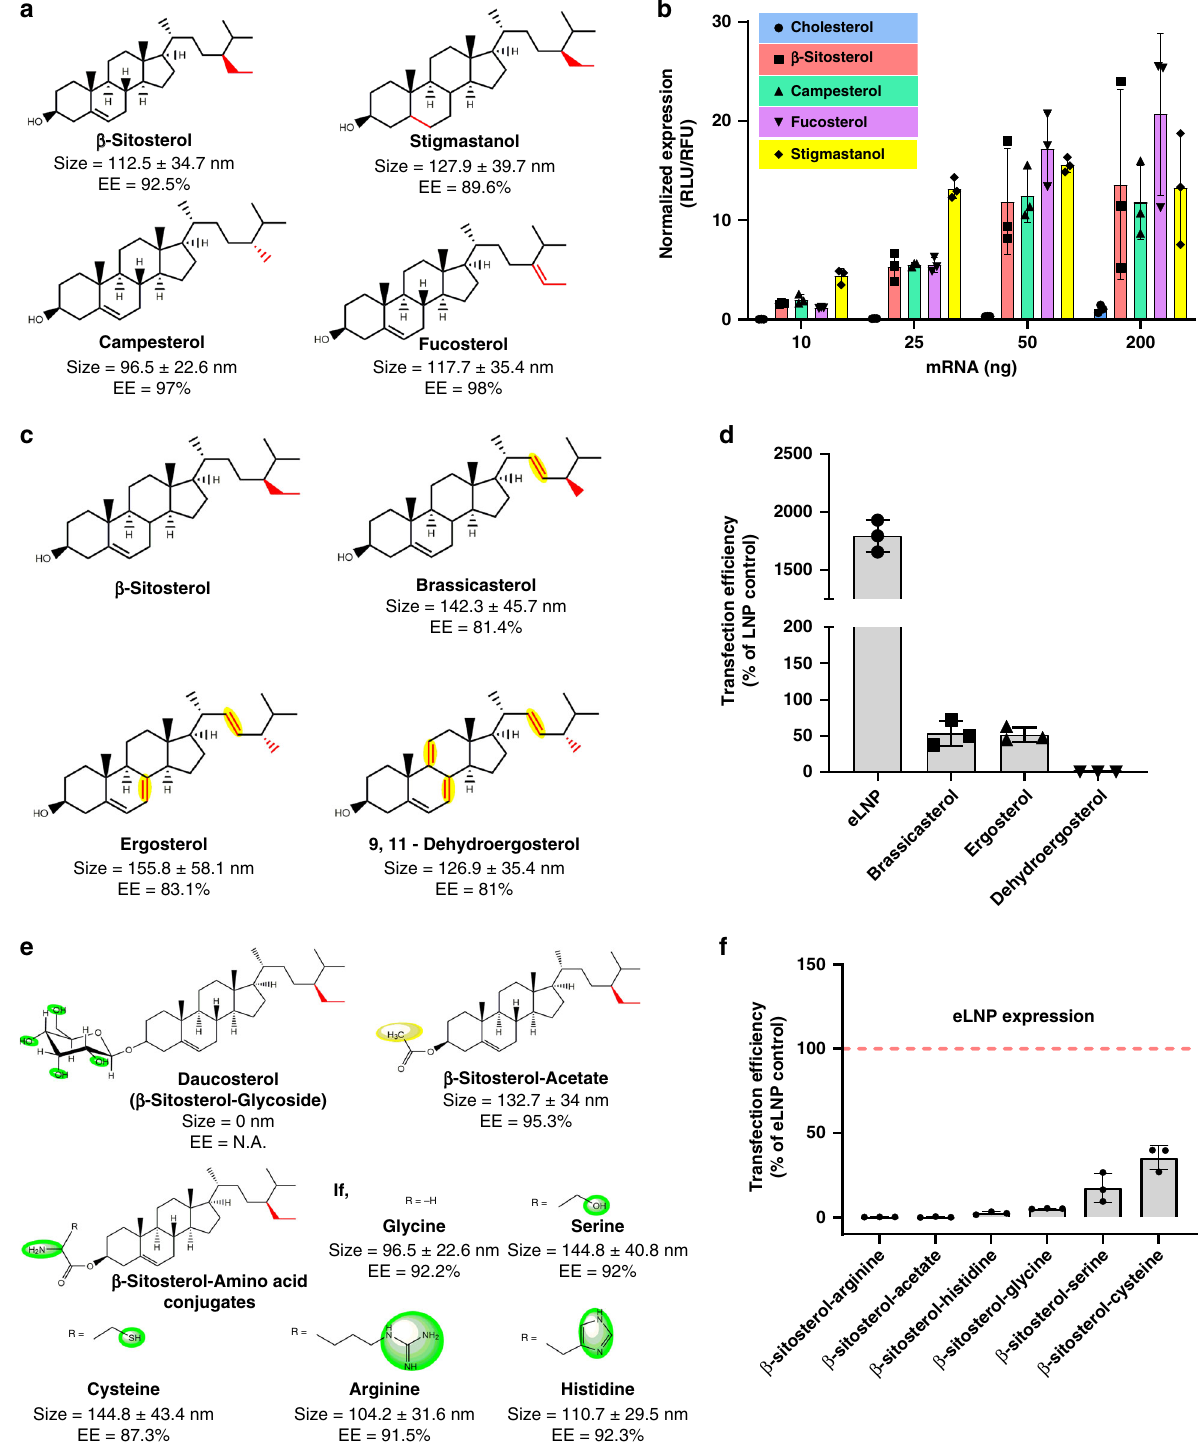
Size = 144.8 ± 43.4 nm EE = 87.3% Fig. 2 Structural features of C-24 alkyl derivatives that enhance gene transfection. a – d C-24 alkyl derivatives with variations in the tail and body were screened for their effect on size, mRNA encapsulation ef fi ciency ( EE ), and transfection ef fi ciency of LNPs (dosed at 10 – 200 ng mRNA per well for C-24 alkyl derivatives in b and 50 ng mRNA per well for sequential addition of double bonds in d ). The variations of these structures from cholesterol and β -sitosterol are depicted as red and yellow, respectively. e – f Structural modi fi cation of the head group in β -sitosterol with either amino acids (polar) or acetate (non-polar) was also evaluated for its effect on nanoparticle size, encapsulation, and transfection of LNPs (200 ng mRNA per well). The color code is indicative of polarity (green), non-polarity (yellow), and structural difference from cholesterol (red). Horizontal dashed red line represents eLNP expression set to 100 percent. All experiments were conducted with n = 3; mean ± SD. Source data are provided as a Source Data fi